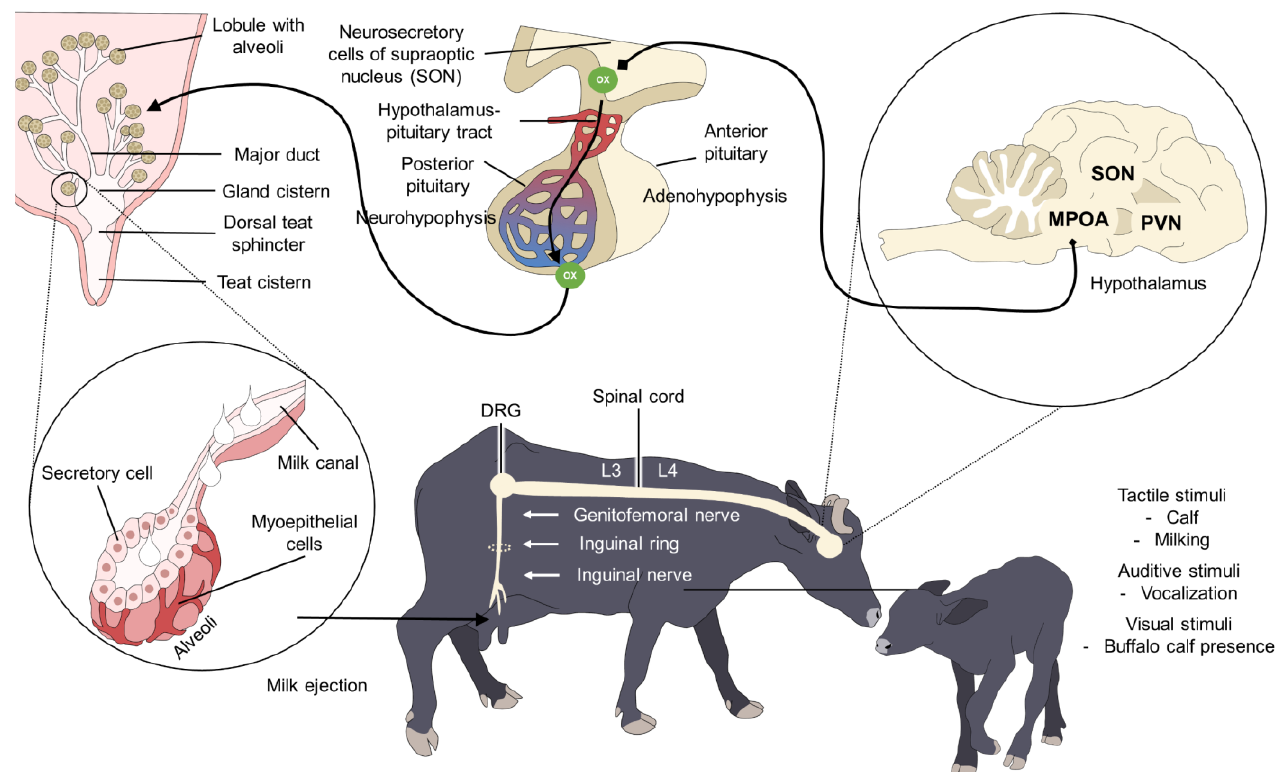
Figure 3. The neurophysiology of milk ejection in dairy buffalo cow. Tactile stimulation of the MG is transformed into nerve impulses that are transmitted by the inguinal nerve to the inguinal ring, which continues as the genitofemoral nerve whose roots enter lumbar pair 3° and 4° (L3, L4), reaching the ganglion of the dorsal root (DRG). There, the impulses are modulated and transferred by the ascending pathway to the cerebral nuclei of the hypothalamus (PVN, SON) and then to neurohypophysis for oxytocin (Ox) synthesis. After its release, oxytocin is stored in the neurohypophysis and later secreted into the bloodstream where it reaches the Ox receptors in the MG and contracts alveolar tissue cells to trigger milk ejection. MPOA: medial preoptic area; PVN: paraventricular nucleus; SON: supraoptic nucleus.